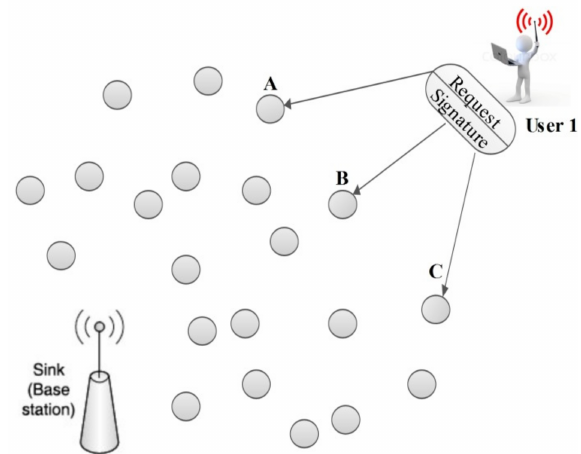
Figure 1. Dissemination of a user message in wireless sensor